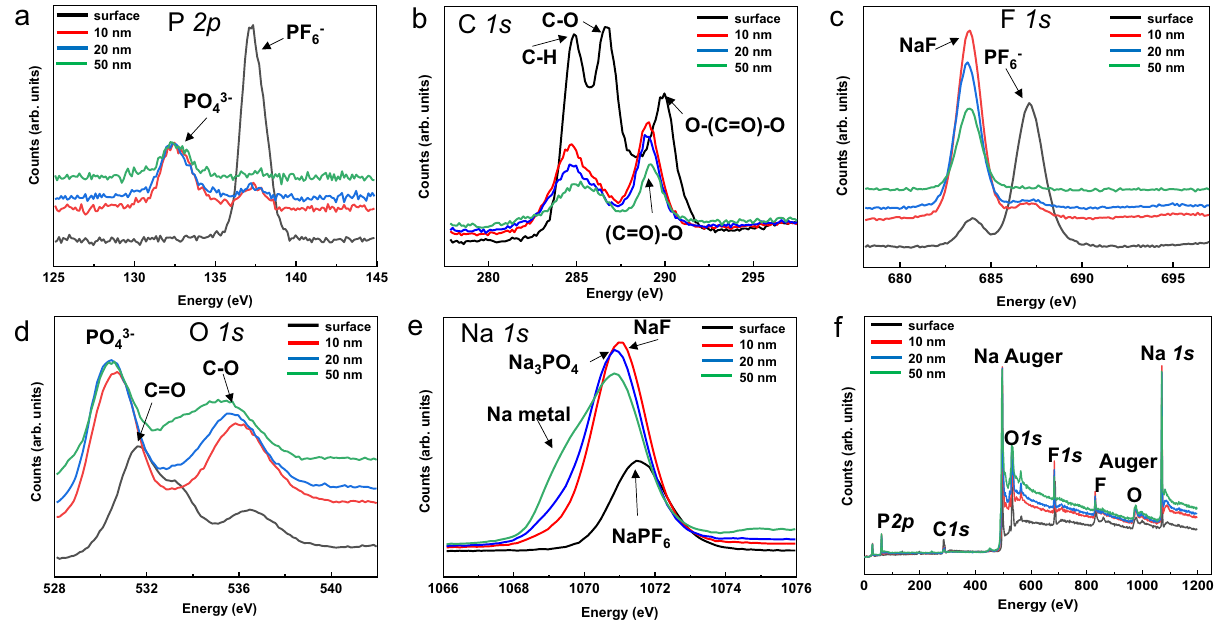
Fig. 5 XPS depth pro fi ling analysis of the Na dendrites in EC:DMC-FEC electrolyte at the 1st cycle. a P 2 p , b C 1 s , c F 1 s , d O 1 s , e Na 1 s peaks, f full spectra showing all detected elemental peaks.